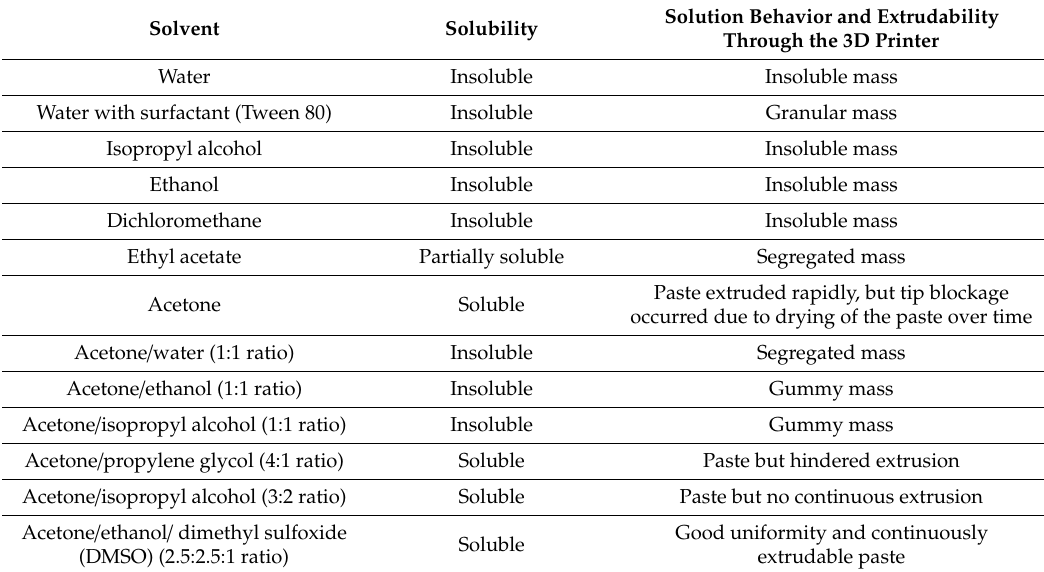
Table 1. Miscibility / solubility profile of cellulose acetate in di ff erent solvents and the resulting solution behaviour, along with extrudability characteristics of the paste through the 3D printer. Solution Behavior and Extrudability Solubility Through the 3D